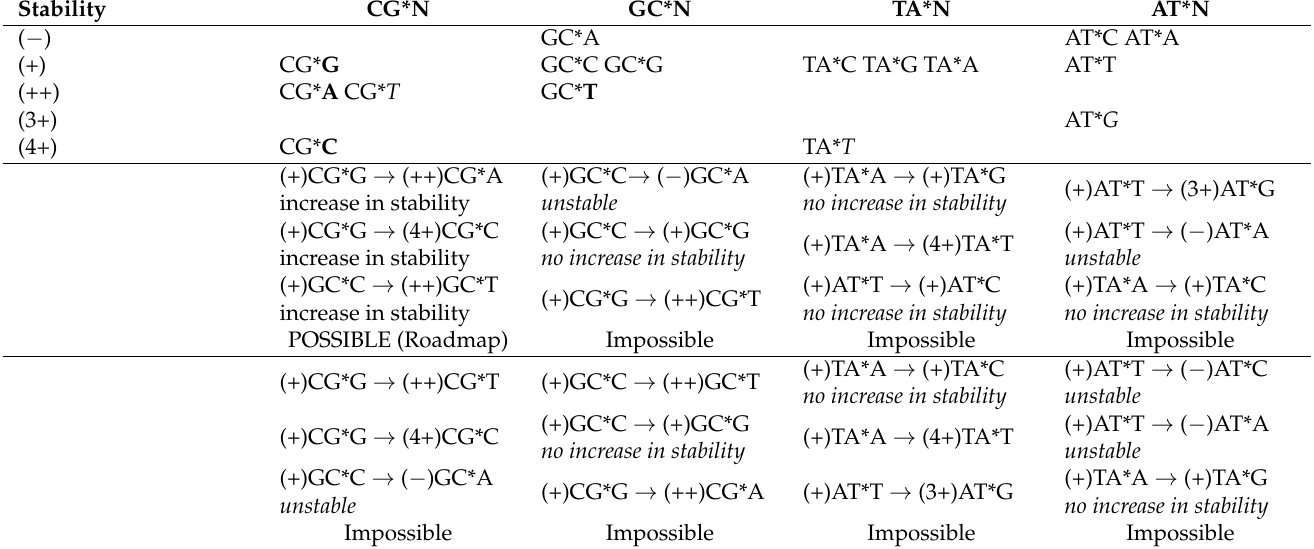
Table 1. Selective pressure due to the unique roadmap with increasing